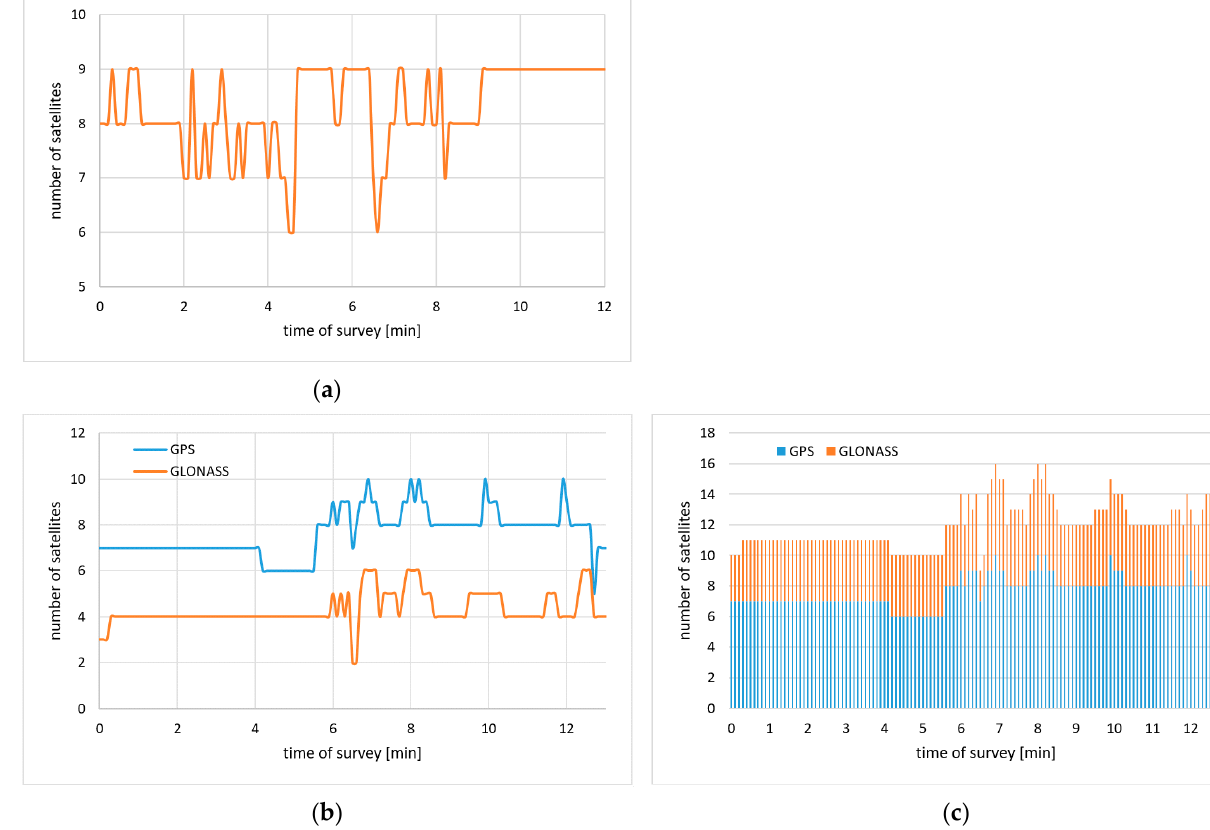
Figure 9. Sky plot with four systems satellites for 10° cut off angle ( a ), the view of the upper hemisphere by USV using spherical camera ( b ), sky plot with satellites visible by USV ( c ). In Figure 10 are presented the number of satellites of individual GNSS system (left column) and total number of satellites in cumulated form.